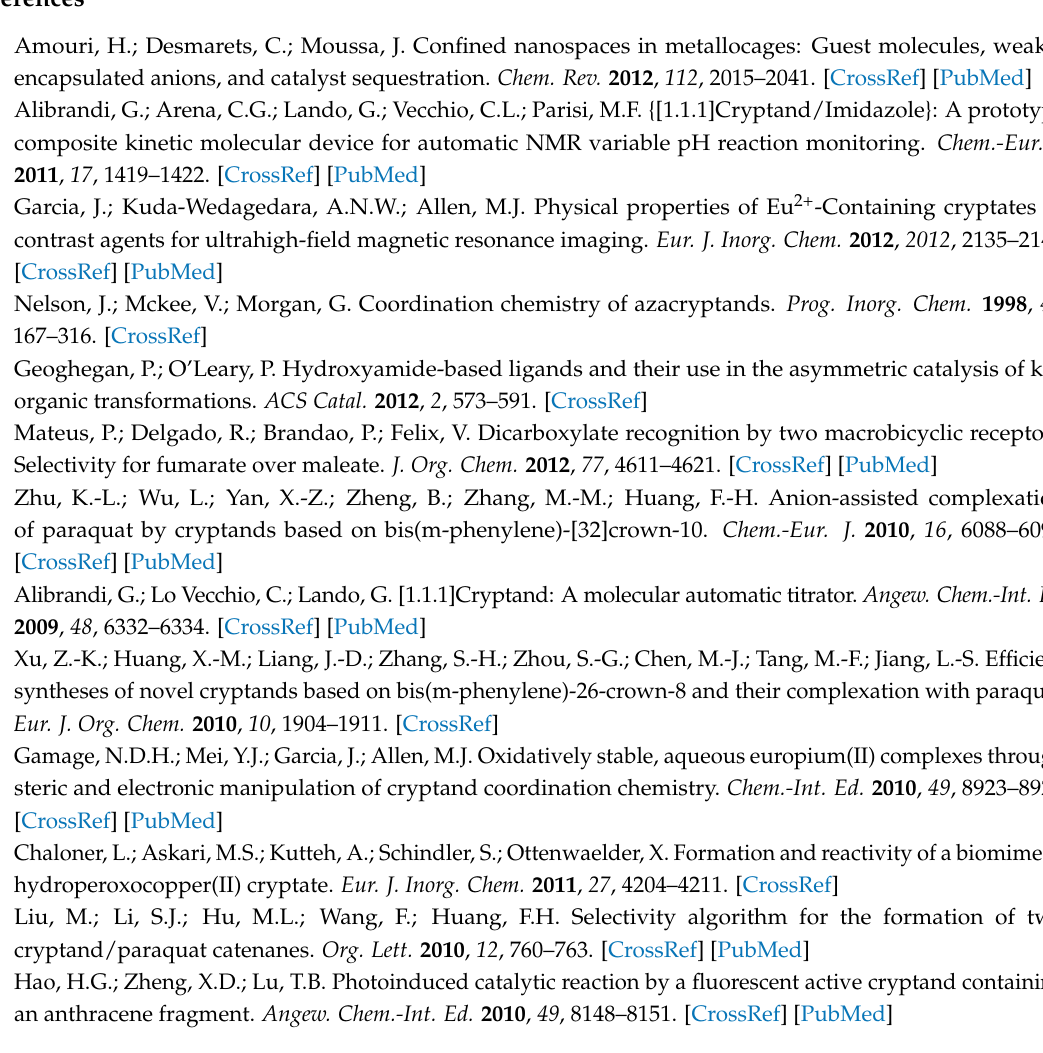
Supplementary Materials: Supplementary materials are available online. Figure S1: The TG-DTA curves of compound 3; Figure S2: The TG-DTA curves of compound 4; Figure S3: The TG-DTA curves of compound 5; Figure S4: The TG-DTA curves of compound 6; Figure S5: The TG-DTA curves of compound 7; Figure S6: Photoluminescent properties of the L 1 and complexes 1 – 7 in DMF; Figure S7: Photoluminescent properties of the L 1 and complexes 1 – 7 in DMSO; Figure S8: The UV-vis absorbance spectrum of the L 1 and complexes 1 – 7 in DMF; Figure S9: The UV-vis absorbance spectrum of the L 1 and complexes 1 – 7 in DMSO. Author Contributions: Z.M. and D.Y. conceived and designed the experiments; X.X., Q.W., F.M., X.L., Y.H. and J.L. performed the experiments; Z.M. and Y.Z. analyzed the data; D.Y. contributed analysis tools; Z.M. and X.X. wrote the